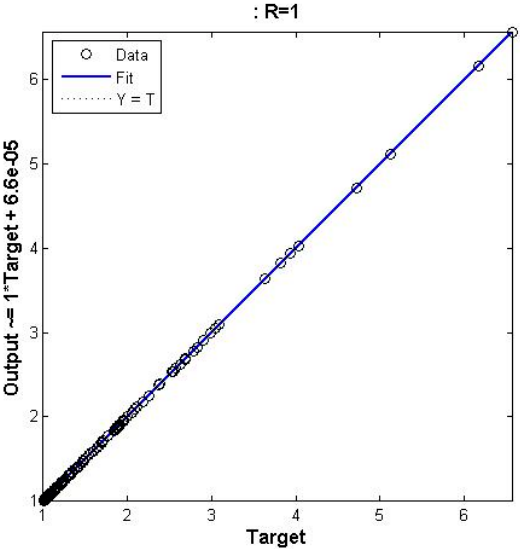
Figure 10. The regression plot measure of the suitability of TDNN. error histogram plot showed how the error sizes were distributed. Typically, most errors were near zero, with very few errors far from that. The value at the bottom of the blue rectangle is the error value. The value on the vertical axis is the number of times this error value appeared among the data.